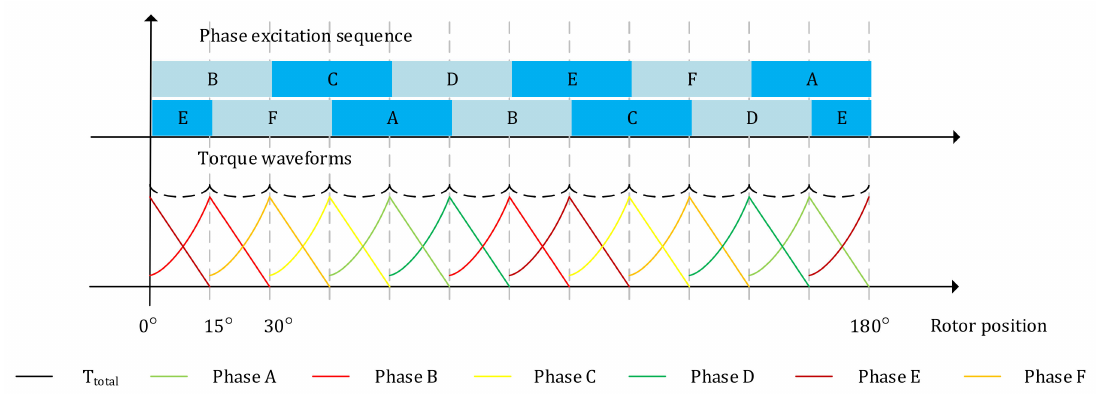
Figure 9. Working process of the proposed SRM in [61].